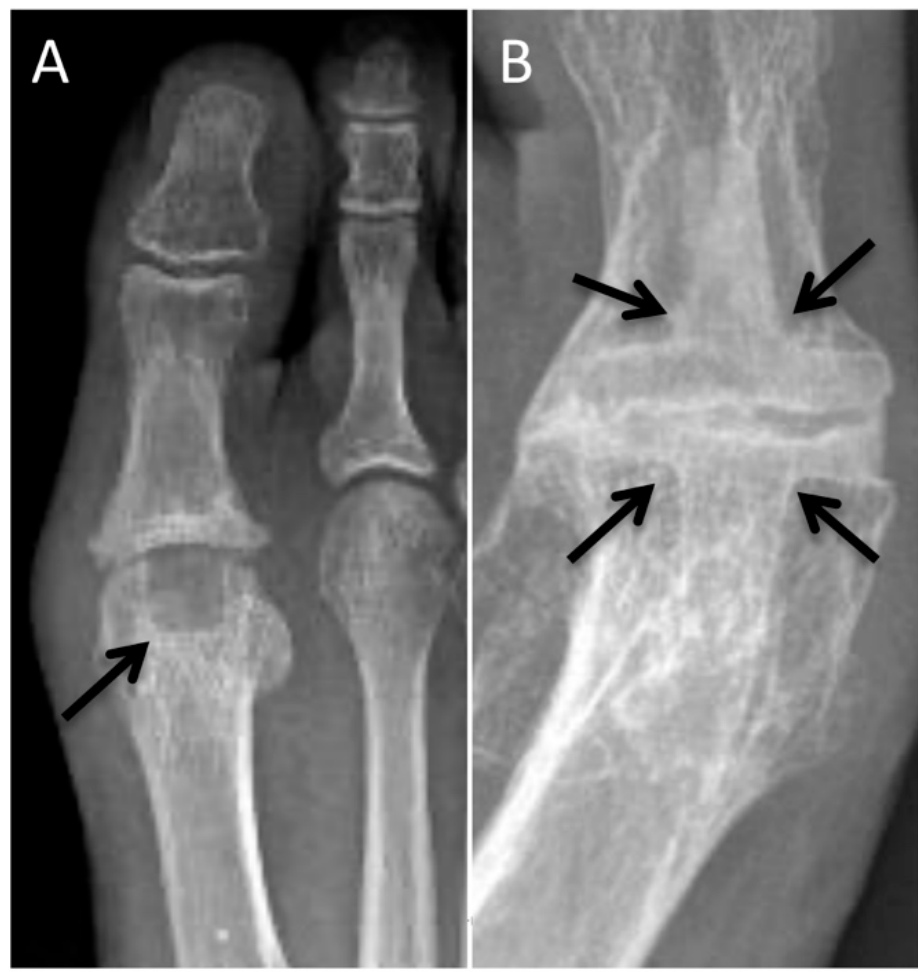
Figure 9. Implants. ( A ) AP radiograph demonstrating postoperative changes related to Cartiva implant (arrow) with geographic rectangular lucency in the first metatarsal head. ( B ) AP radiograph showing silastic implant (arrows) of the first MTP joint. Note flat articular surfaces and triangular shape of stems.